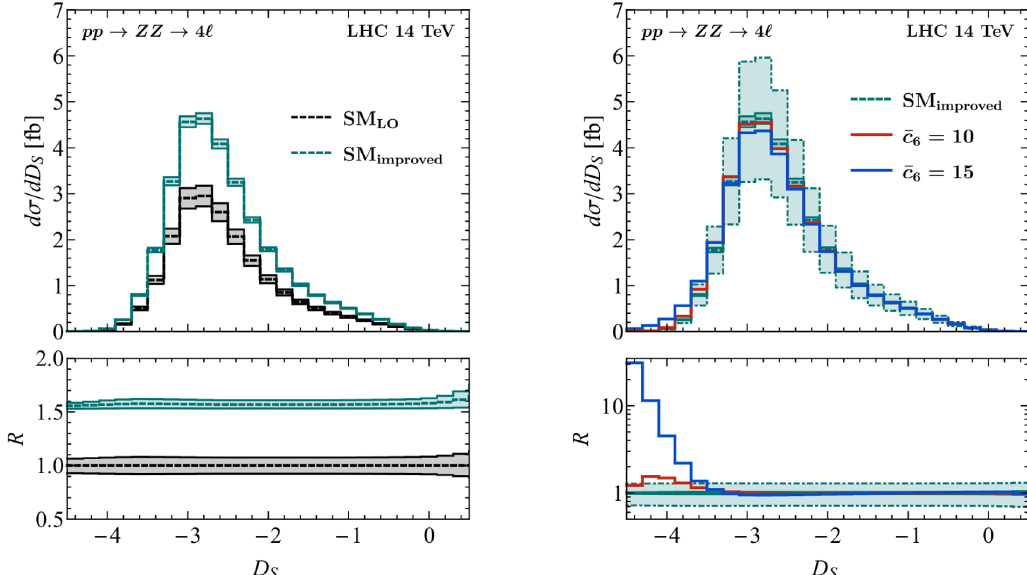
Figure 5. Left: D S distributions for the pp → ZZ → 4 ‘ process in the SM obtained at LO (dashed black) and the QCD-improved prediction (dashed green). The lower panel shows the ratio to the LO SM prediction and the uncertainty bands been obtained using the scale variations from table 1. Right: D S spectra for pp → ZZ → 4 ‘ production in the SM (dashed green) and for ¯ c 6 = 10 (solid red) and ¯ c 6 = 15 (solid blue). The thin green band corresponds to the scale uncertainties of the QCD-improved SM predictions for D S , while the wide green band represents half of the relative difference between the QCD-improved and the LO SM predictions for ME-based discriminant. The lower panel shows the ratio of the BSM and SM predictions including the aforementioned uncertainty √ bands. All distributions assume pp collisions at s = 14 TeV and the improved SM as well as the BSM predictions have been obtained by means of (4.2). Additional explanations can be found in the main